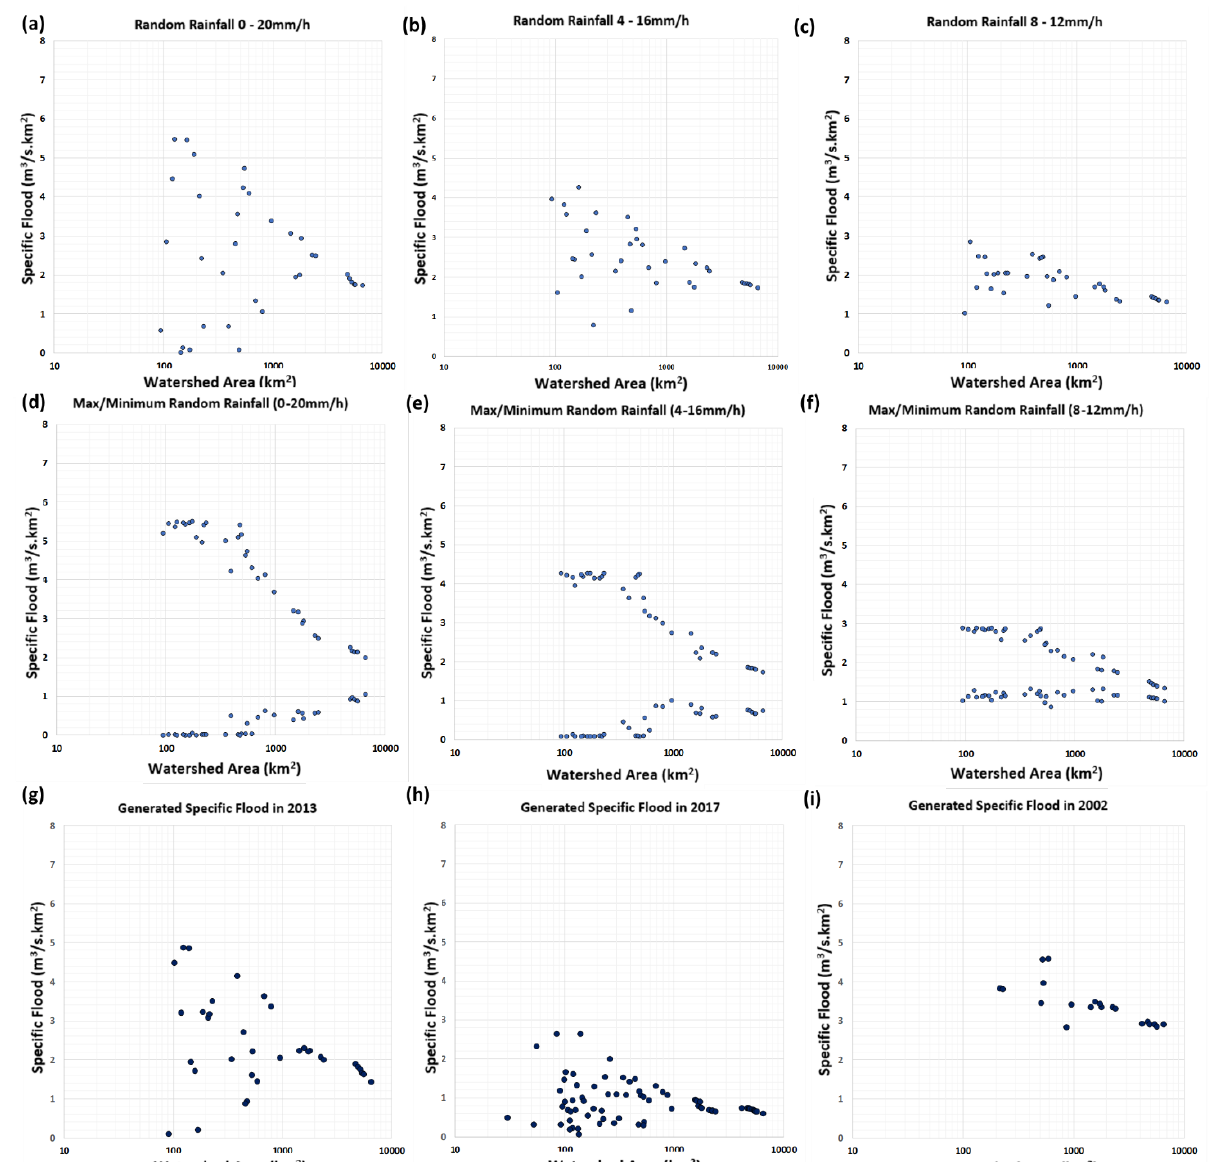
Figure 8. Specific flood based on the different size of rainfall distribution (( a – c ) Simulation cases, ( d – f ) maximum and minimum size collection of specific floods for 30 trials, ( g – i ) real cases).